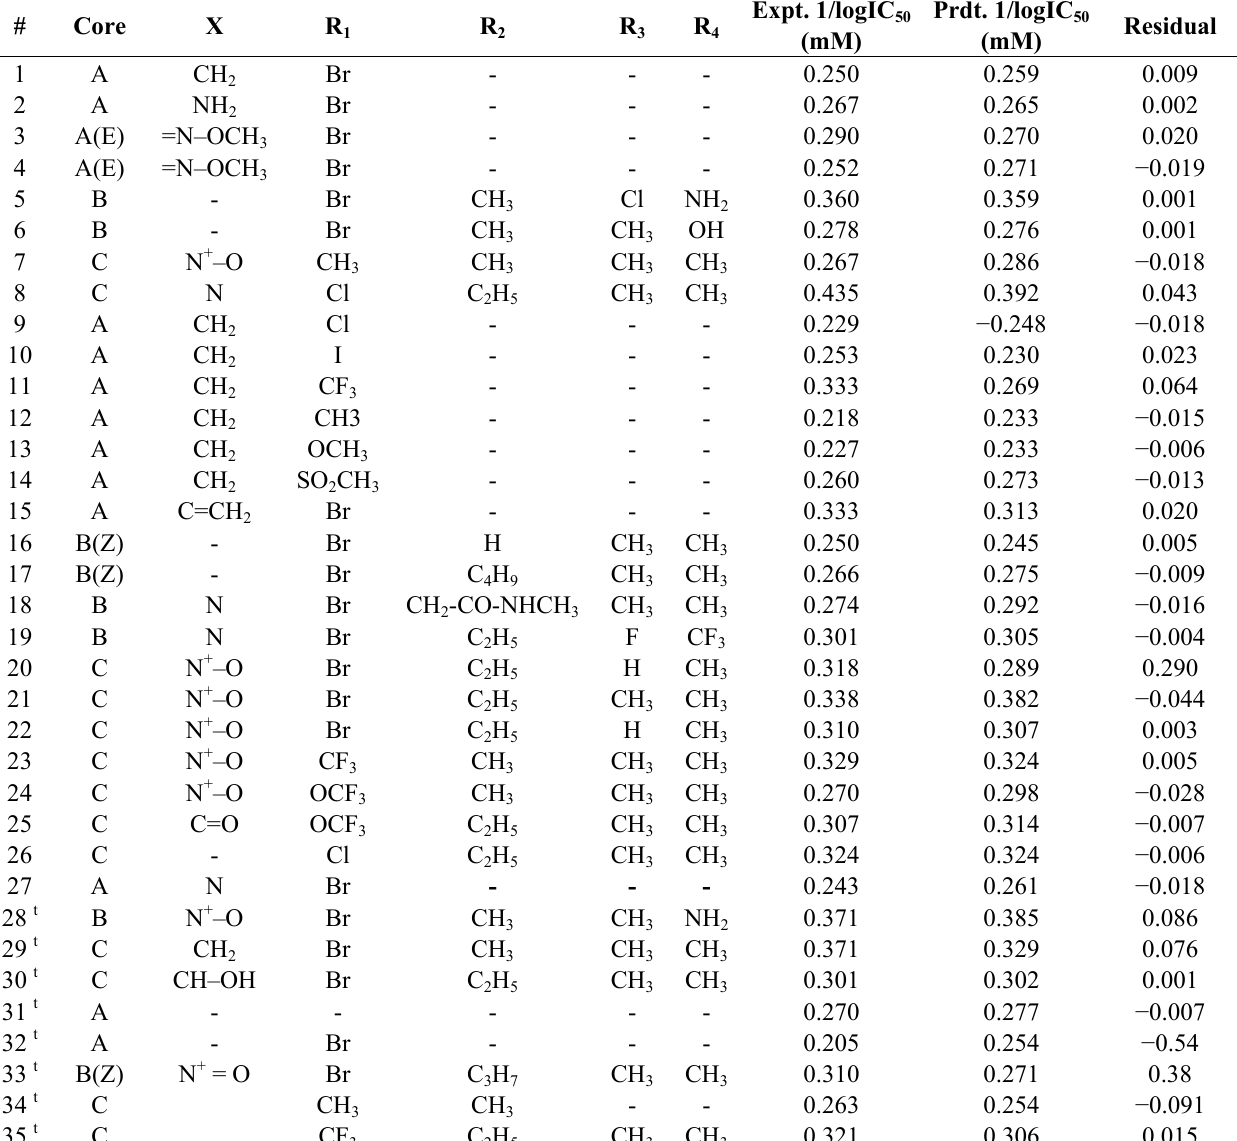
Table 1. Dataset analyzed for 3D QSAR with experimental 1/logIC and residual